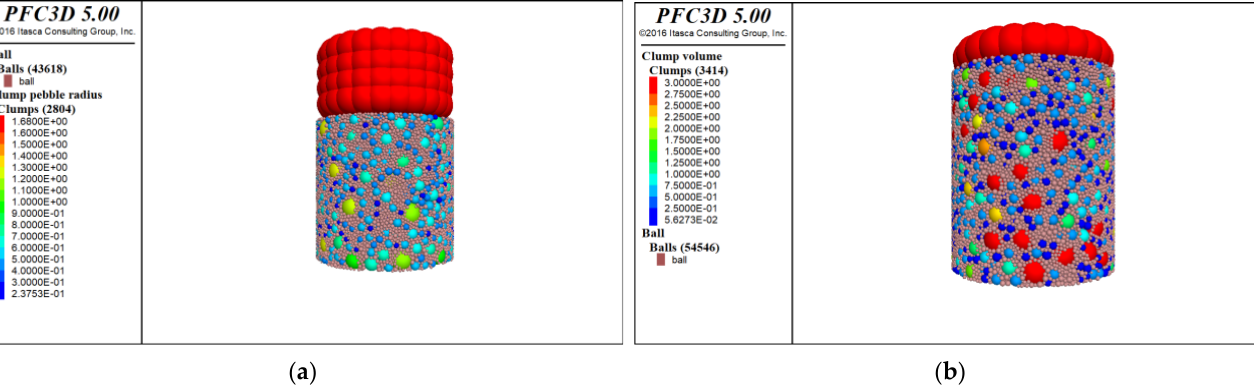
Figure 3. ( a ) Compaction molding and ( b ) vibration molding discrete element models. In the figure, E is abbreviation for exponent, for example, the number 1.68E0 stands for 1.68.